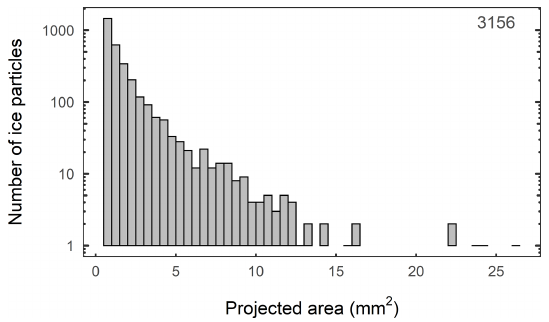
Figure 3. The number of analysed ice particles ( n = 3156) by in- tervals of projected area (mm 2 ) roughly followed a power function. Analysed ice particles captured by the camera during the 15min in- tervals prior to the radiosonde launches throughout the whole time span of interest (28 February 2019 to 7 April 2020) were consid-